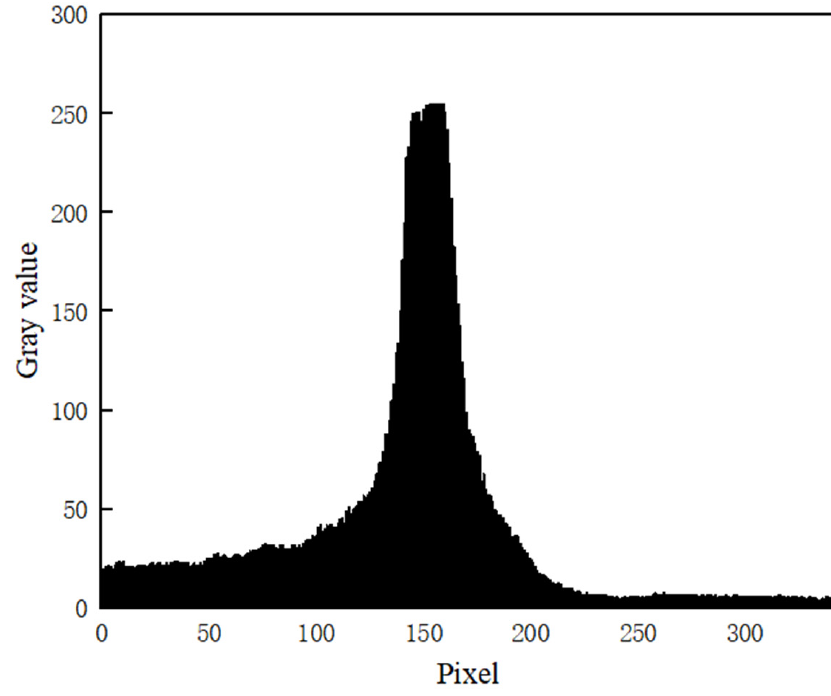
Figure 4. Cross section of light stripe with Gaussian-like distribution.